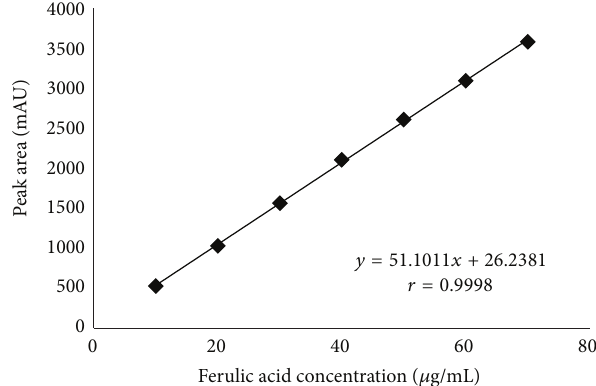
Figure 4: Mean calibration curve obtained for FA using working standard solutions at the concentration range of 10.0 to 70.0 𝜇 g/mL ( 𝑛 = 3 ).